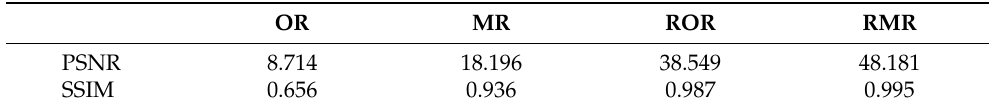
Figure 7. Visualized results obtained from different data preprocessing methods, ( a ) is the directly cut Radon data; ( b ) is the restored result of ( a ); ( c ) is the fused Radon data; ( d ) is the restored result of ( c ); ( e ) is the Radon ground truth. Table 2. Restoration results of OR and